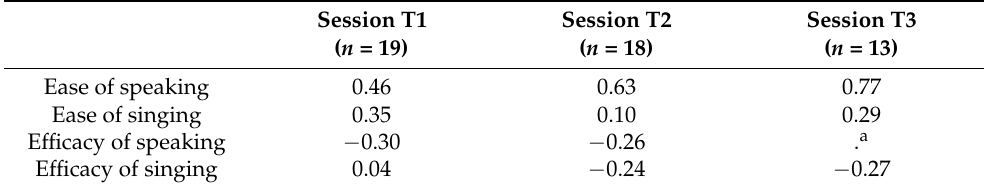
Table 2. Pearson correlation between ease and efficacy of singing/speaking and maternal musical experience in the three sessions. Session T1 Session T2 Session T3 ( n = 19) ( n = 18) ( n = 13) Ease of speaking 0.46 0 . 63 0 . 77 Ease of singing 0.35 0 . 10 0 . 29 Efficacy of speaking −0 . 30 −0 . 26 . a Efficacy of singing 0 . 04 −0 . 24 −0 . 27 Note. a All the 13 mothers at the Session 3 answered Yes. In bold significant correlations at p < 0.05.